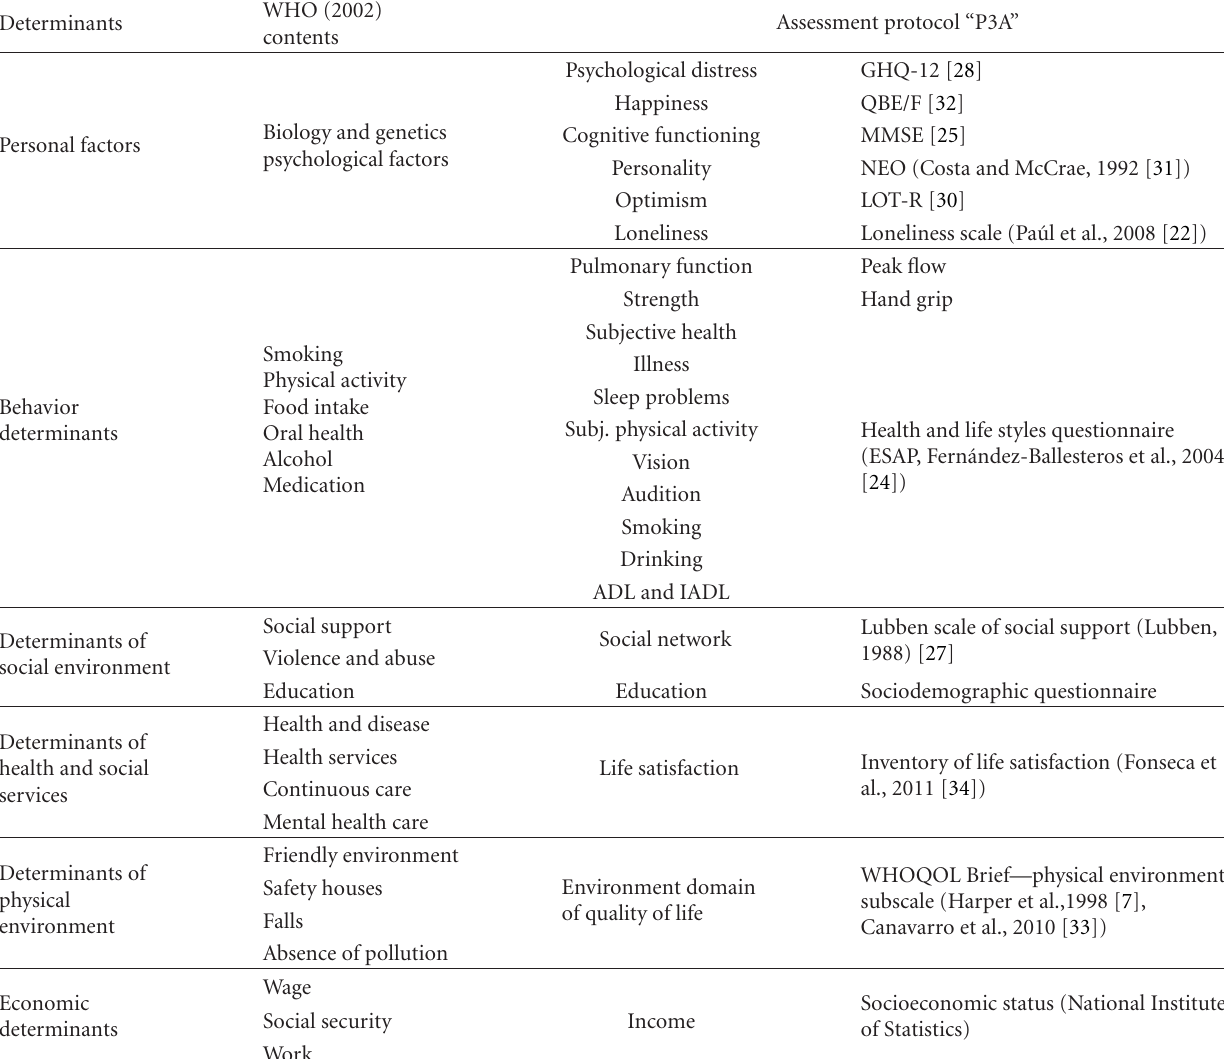
Table 1: Instruments used for each of the WHO’s active ageing model